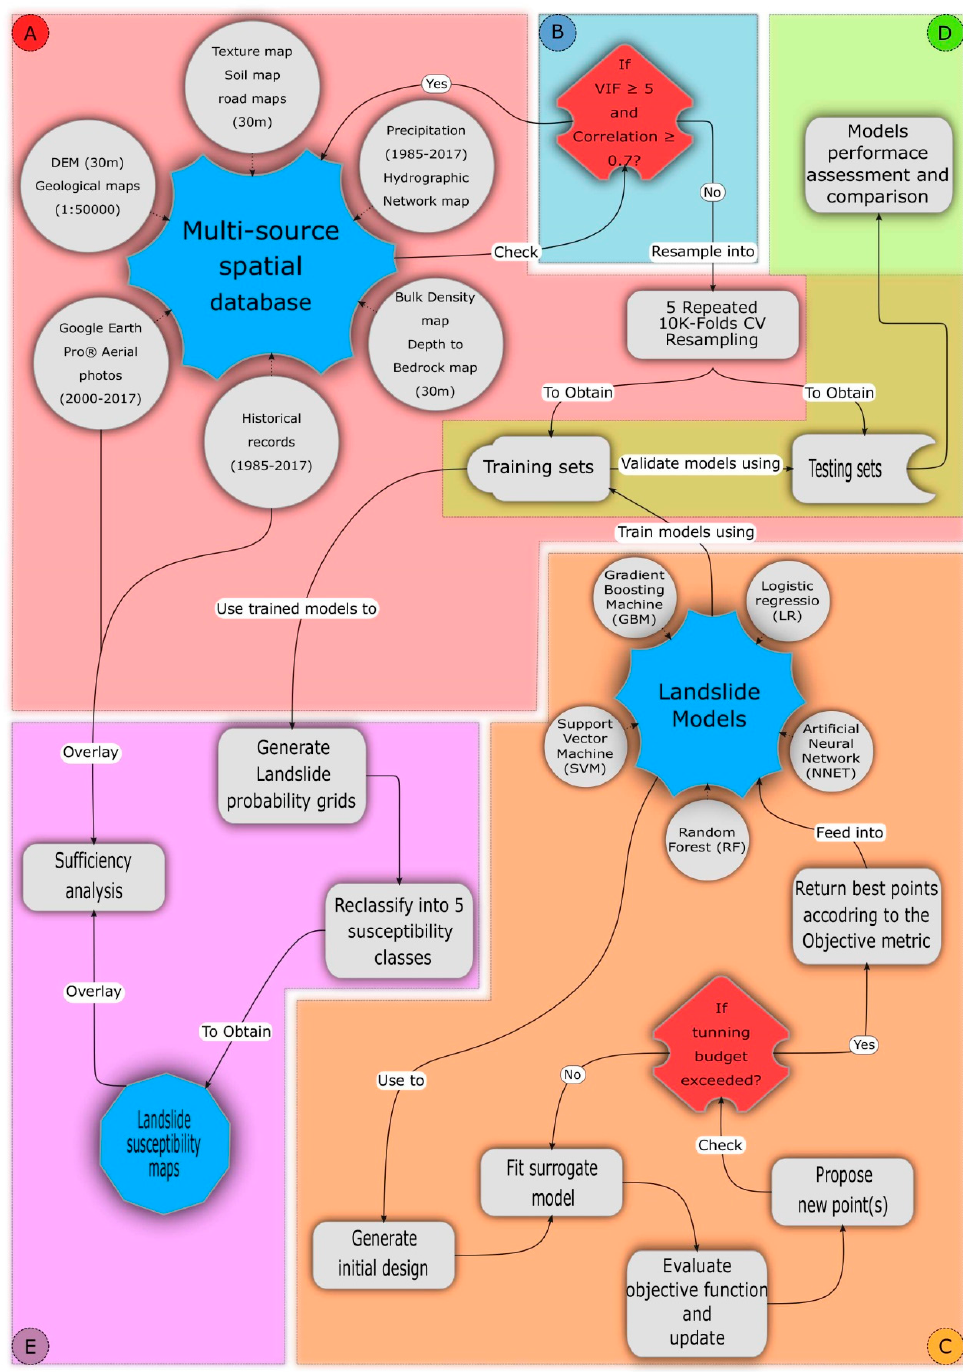
Figure 5. The overall concept of the used methodology for this research: ( A ) construct a spatial database that will serve as an input dataset for the study from the landslide inventory map and the landslide conditioning factors; ( B ) Analyzing and optimizing the landslide conditioning factor based on the Pearson correlation and Variance Inflation Factors analysis (VIF) results; ( C ) Model configuration and implementation using the desired hyperparameters optimization strategy; ( D ) Model training, validation, and comparison using 5-times-repeated 10 k-folds cross-validations (CV) and the selected performance indicator metrics; ( E ) susceptibility maps generation and evaluation based on the appropriate assessment strategy.